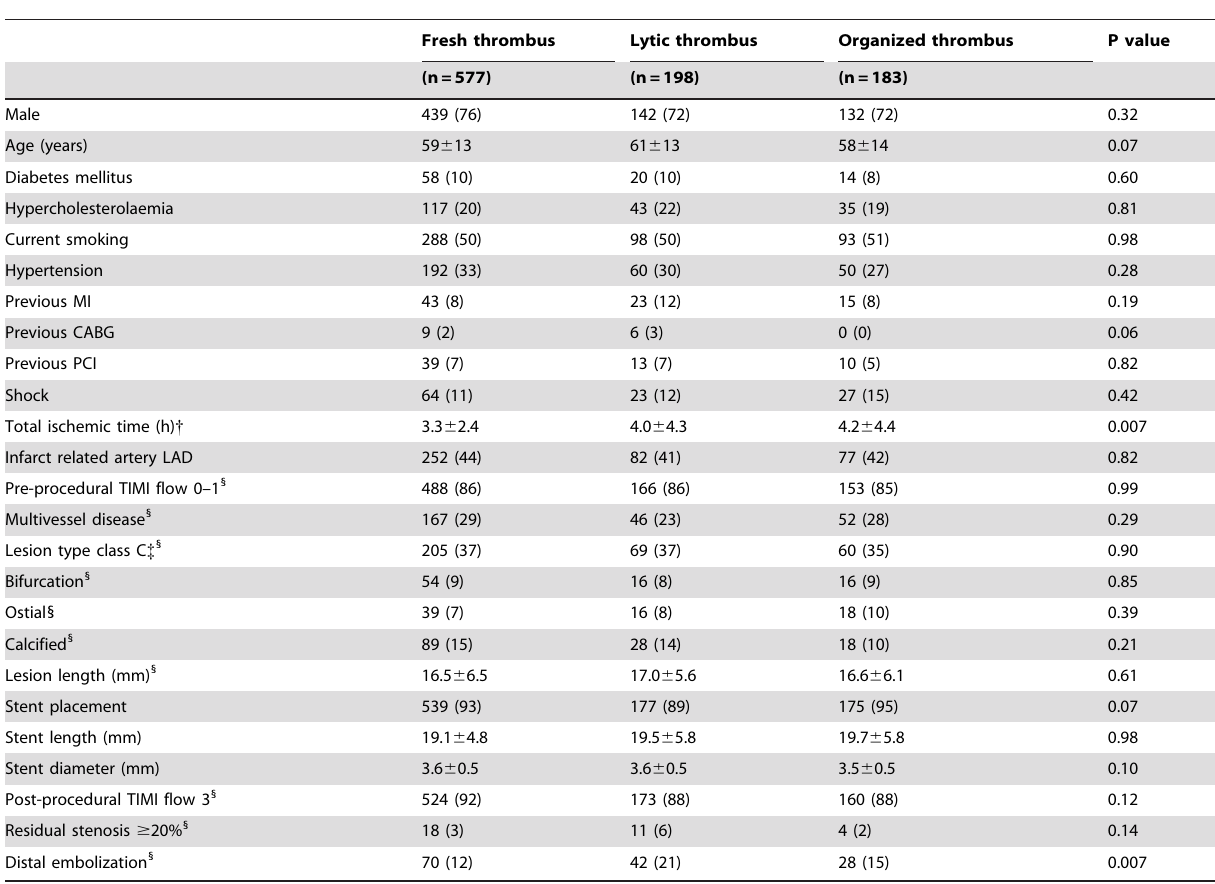
Table 3. Clinical, angiographic and procedural characteristics of the 959 patients with classifiable